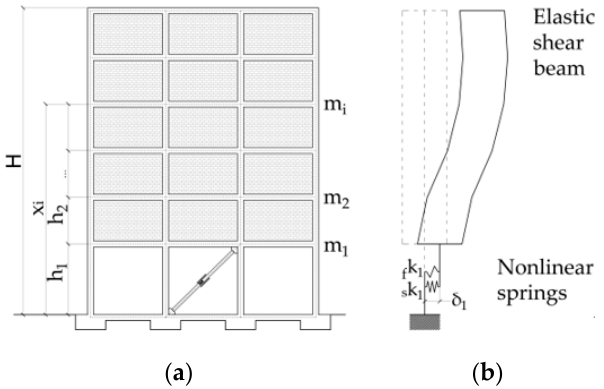
Figure 1. Typical structure with dampers’ ( a ) elevation, and analytical model ( b ).